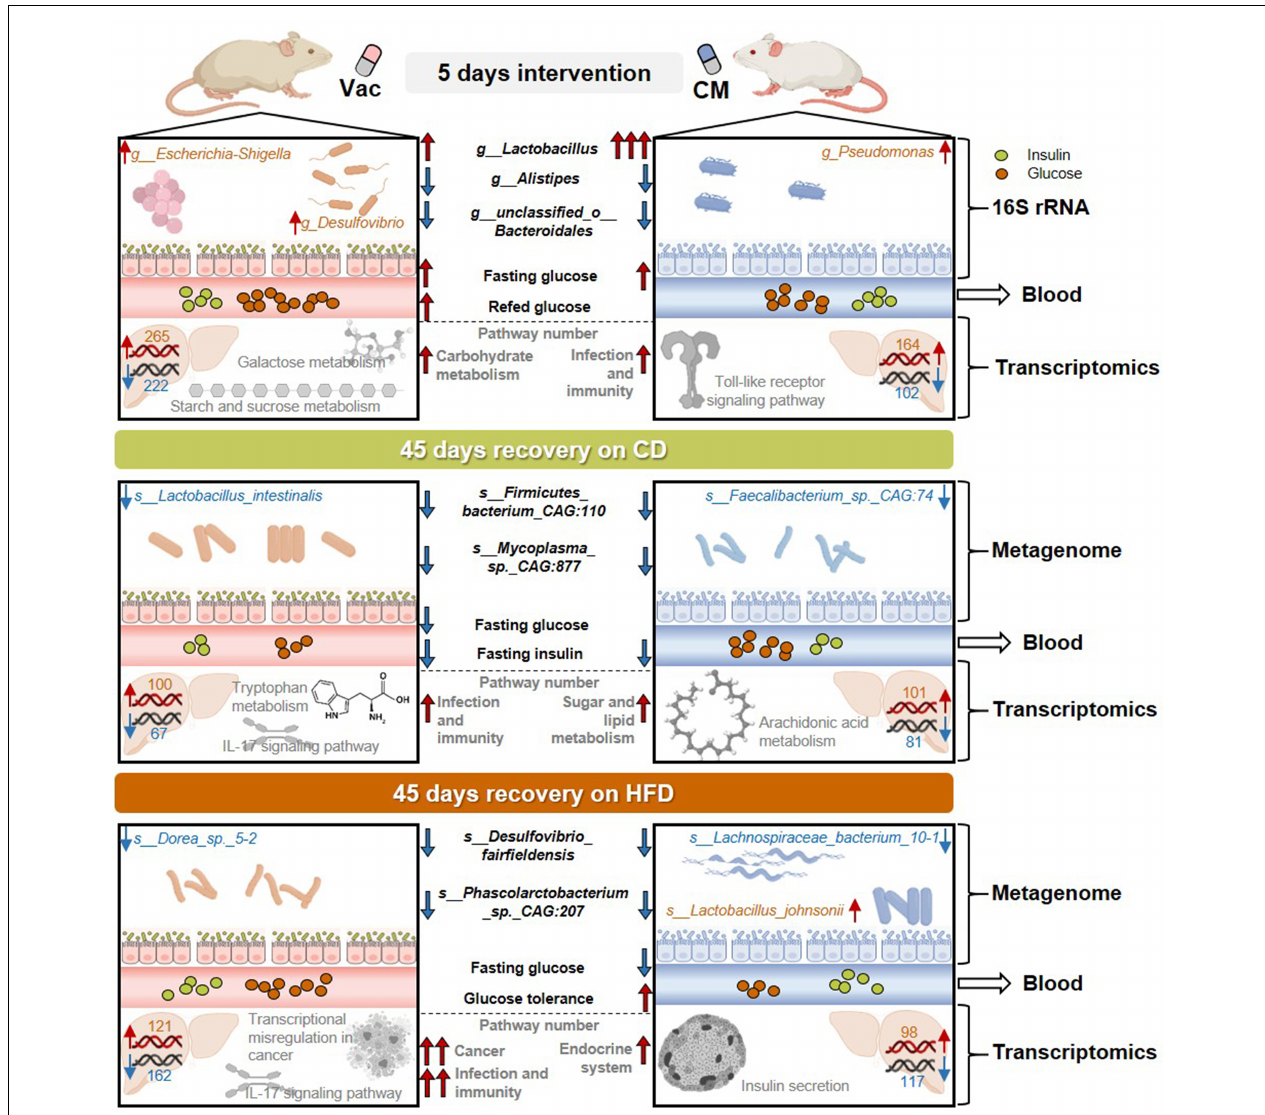
FIGURE 8 | The effects of short-term antibiotic intervention on gut microbiota composition and host metabolism were long-lasting, antibiotic-specific, and diet-dependent. The 5-day intervention with Vac and CM dramatically influenced gut microbiota composition, in which Vac and CM had unique or common effects on regulating the relative abundance of certain gut bacteria. In addition, short-term Vac and CM intervention differential affected blood glucose homeostasis and liver transcriptome, by mainly regulating carbohydrate metabolism-related pathways and infection- and immunity-related pathways, respectively. After a 45-day recovery on either CD or HFD, gut microbiota composition and function, as well as blood glucose imbalance, were partly restored. However, when rats were recovered on CD, certain species in Lactobacillus genus and in Faecalibacterium genus were reduced at post-Vac and post-CM recovery states, respectively. Differences in infection and immunity-related pathways were apparent after recovery from Vac treatment, while sugar and lipid metabolism-associated pathways were shifted after recovery from CM treatment as revealed by hepatic transcriptome. When rats were recovered on HFD, the relative abundance of species in Desulfovibrio and Lachnospiraceae genera was reduced, whereas Lactobacillus johnsonii was elevated significantly at post-CM recovery state. Moreover, HFD feeding worsened the extent of post-antibiotic recovery in Vac-treated rats including the alterations of infection, immunity, and cancer-related pathways and in CM-treated rats including endocrine system-associated pathways. CD, chow diet; CM, ciprofloxacin and metronidazole; HFD, high-fat diet; Vac,